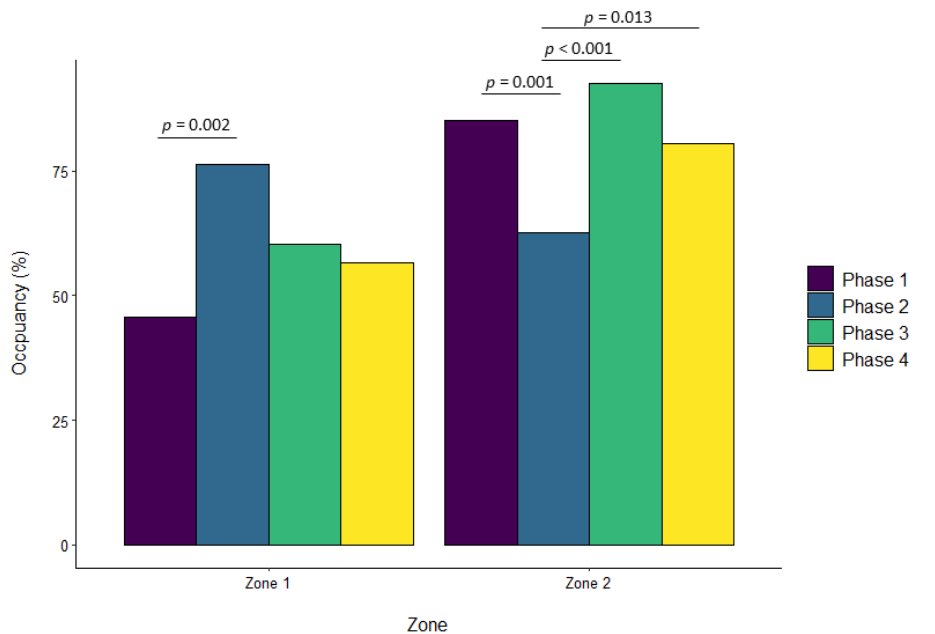
Figure 5. Percent occupancy of each zone by phase for the banteng. Means and standard deviations for fecal glucocorticoid levels by phase for each species are presented in Table 5. Pairwise comparisons of fecal glucocorticoid levels between phases and associations with temperature and day of the week for the banteng are presented in Table 6 and Figure 6. The banteng showed considerable intra-individual variation in changes in glucocorticoids across the study periods. For banteng female 1, glucocorticoids in Phase 4 were significantly lower than in Phase 2. For female 2, glucocorticoid levels in Phase 2 were significantly higher than in Phases 1, 3, and 4; for female 4, glucocorticoid levels in Phase 2 were significantly higher than in Phases 3 and 4. Glucocorticoid levels did not vary significantly by phase in female 3. There were no other significant differences in glucocorticoid levels observed between phases for the female banteng. The banteng bull was not housed with the females or in an area that was viewable to the public in Phases 1 and 2, and glucocorticoids from Phase 3 are not presented due to an injury and temporary removal from the group. There were no significant differences in glucocorticoid levels between Phases 1, 2, and 4 for the bull. Temperature neared a significant inverse relationship with fecal glucocorticoids in female 1 but was not a significant variable in the models for any other banteng. There were no significant differences in fecal glucocorticoids between weekdays or weekend days for any